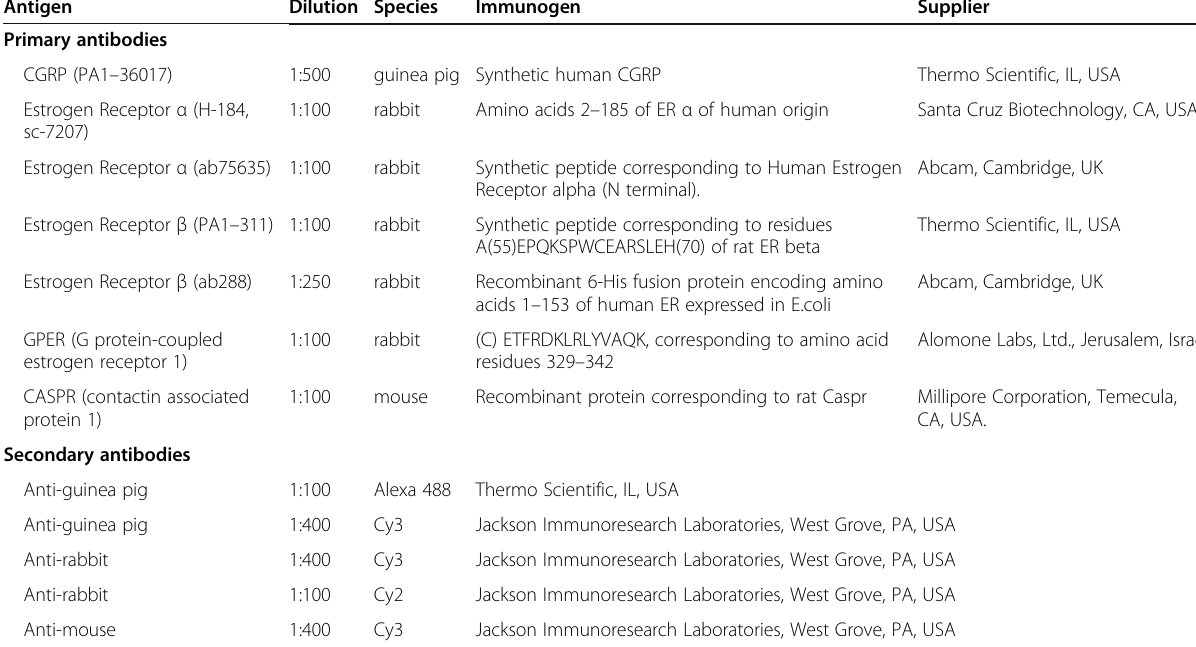
Table 1 Details of primary and secondary antibodies